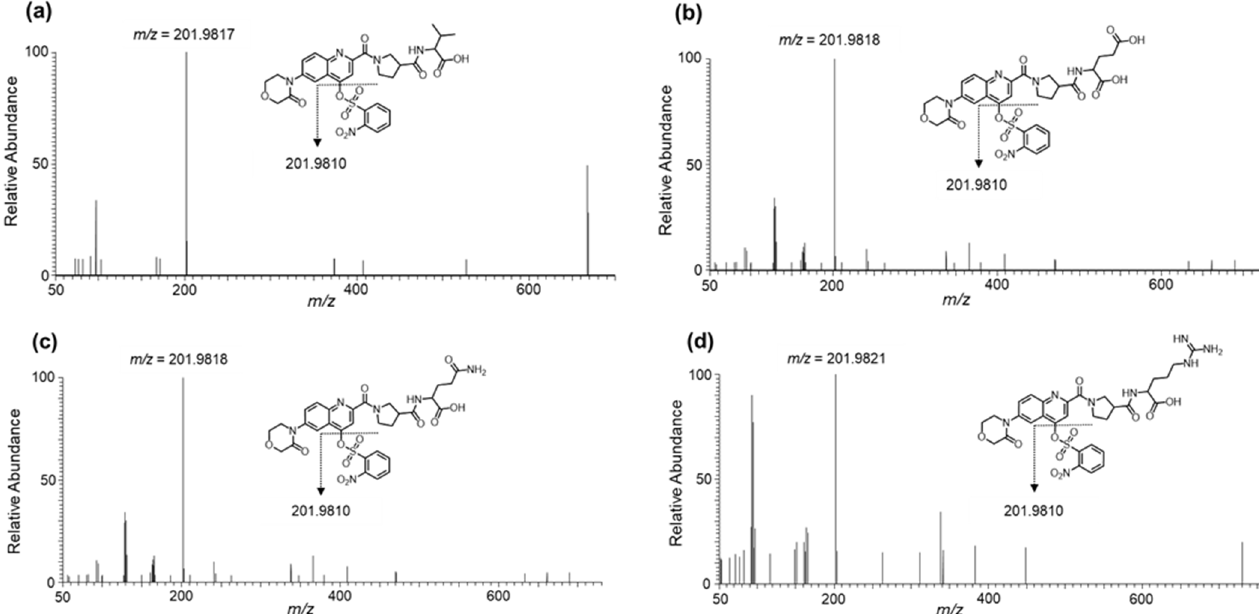
Figure 3. MS/MS spectra of derivatized amino acids: ( a ) Val, collision energy (CE) 30%; ( b ) Glu, CE 30%; ( c ) Gln, CE 30%; and ( d ) Arg, CE 30% with Ns-MOK-( S )-Pro-OSu using ESI (+) mode.